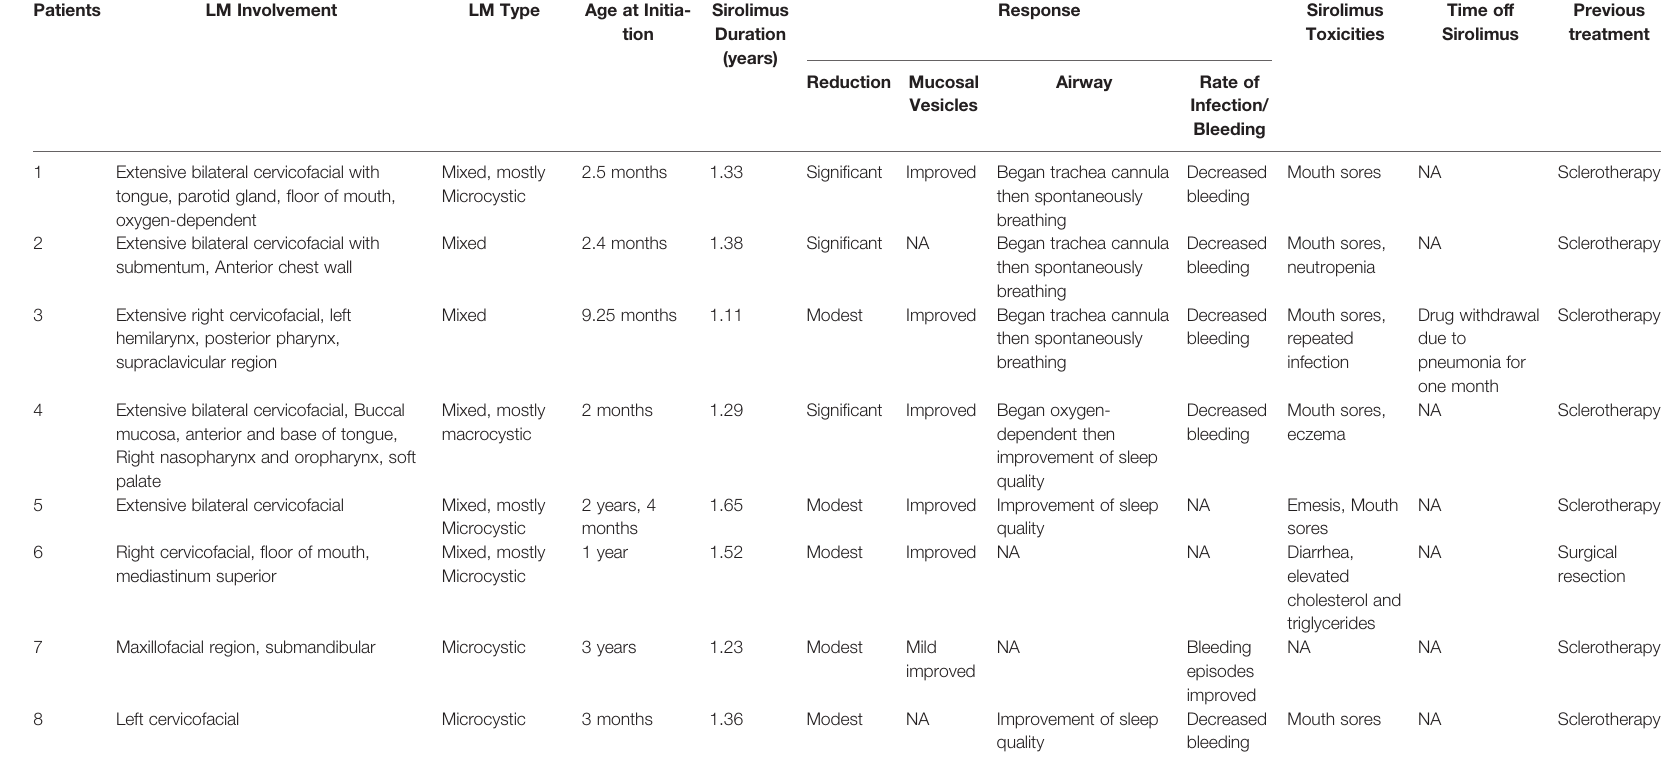
TABLE 1 | Patient Characteristics and Sirolimus